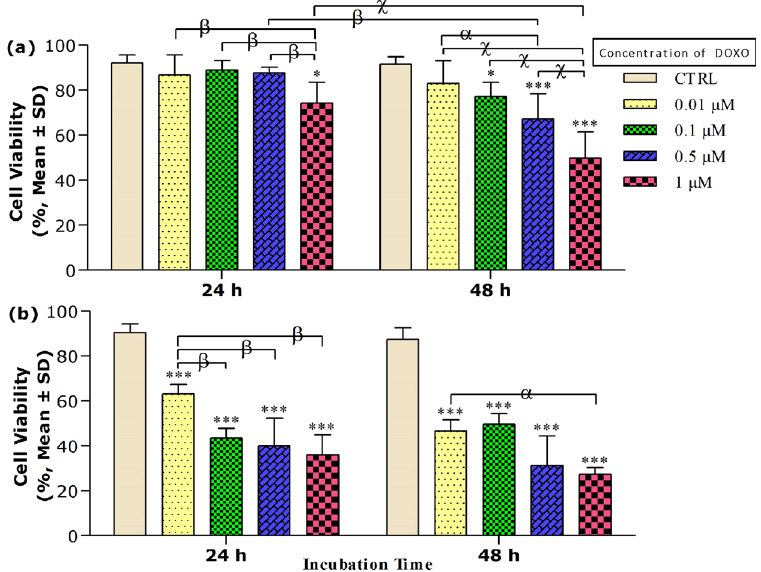
Figure 2. The cell viability results of ( a ) MCF-7 and ( b ) HFF cells treated with DOXO at different concentrations (0.01, 0.1, 0.5 and 1 μ M) for two exposure times (24 and 48 h). The cell viability was determined by Trypan blue assay, and results are expressed as the percentage of viable cells. Data are shown as mean ± SD (n = 3). * P < 0.05; *** P < 0.001 . Significant difference relative to untreated cells (CTRL), and letters ( α , P < 0.05 ; β , P < 0.01 ; χ , P < 0.001 ). Significant differences between treated cells (5 × 2 factorial ANOVA flowed by post-hoc Newman–Keuls multiple comparison